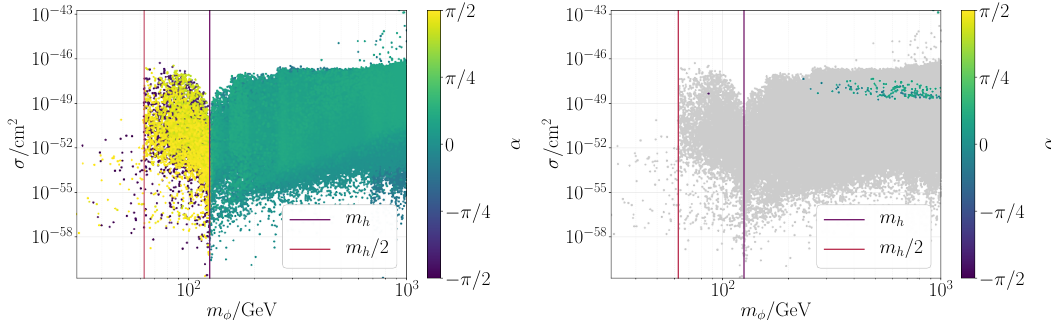
Figure 11 . The SI cross section is shown as a function of the non-SM like Higgs boson mass m φ . The gray points denote the full sample passing all experimental and theoretical constraints. The colored points yield SI cross sections above the neutrino floor, where the color code indicates the mixing angle α . The two vertical lines indicate m φ = m h / 2 and m φ = m h , respectively. On the left-hand side, all of the about 260.000 parameter points fulfilling the theoretical and experimental constraints are plotted. On the right-hand side, only the parameter points that appear above the neutrino floor are plotted in color and all remaining parameter points are shown in